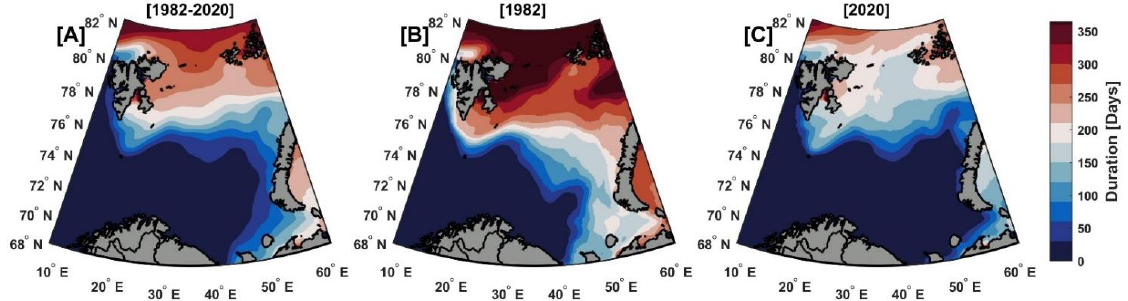
Figure 6. Average duration of sea-ice season (in Days) for ( A ) the whole period (1982 – 2020), ( B ) the beginning (1982), and ( C ) the end (2020) year of the period.